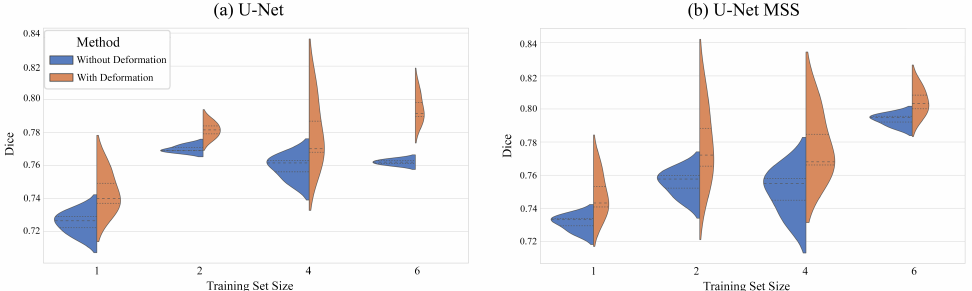
Figure 5. Violin plots showing the quantitative results of the experiments with training set sizes, for U-Net ( a ) and U-Net MSS ( b ) trained with and without deformation-aware learning. Table 2. Quantitative evaluation of the effect of training set sizes on U-net and U-net MSS with and without deformation-aware learning. Without Deformation With Deformation-Aware Learning Model Training Set Size Dice Coeff. IoU Dice Coeff. IoU